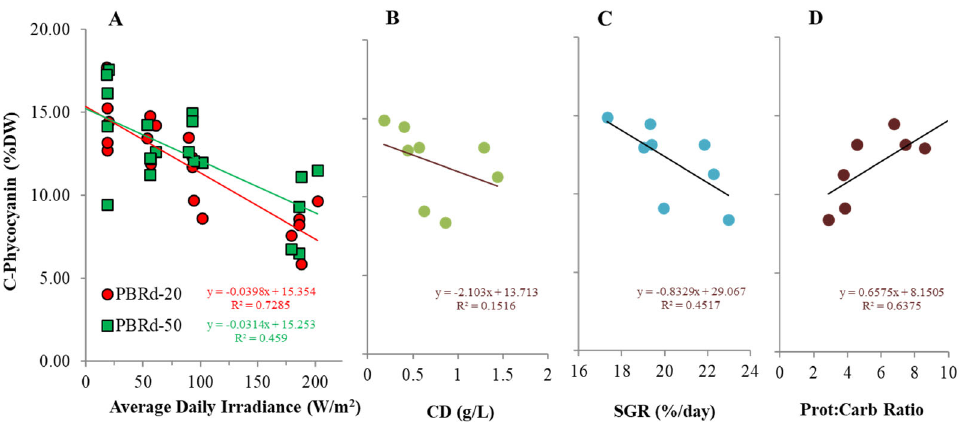
Figure 6. Chlorophyll ‐ a content of an outdoor A. platensis culture in response to daily irradiance ( A ), and its relationships with culture density ( B ), specific growth rate ( C ), and protein:carbohydrate ratio ( D ).